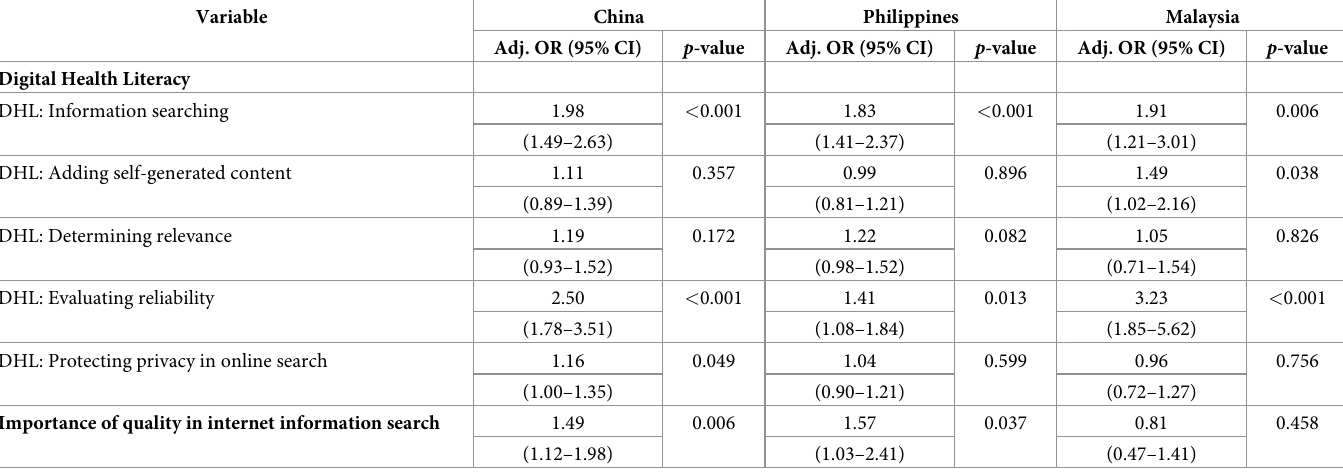
Table 4. Logistic regression of the predictors of information satisfaction among university students from China, the Philippines and Malaysia (n = 4890).